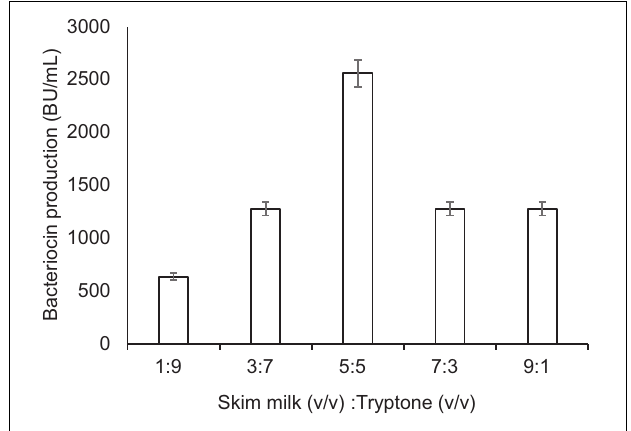
FIGURE 2 | Bacteriocin production in a medium composed of skim milk and tryptone. Different ratios of skim milk and tryptone were made in the formulation by mixing an increasing portion of skim milk (10%; w/v; from 1 volume to 9 volumes) with a corresponding decreasing portion of tryptone (10%, w/v; 9 volumes to 1 volume). For growth conditions, see legend in Figure 1 . The bacteriocin activity was measured after 9 h of culture incubation. Standard deviations were based on triplicate